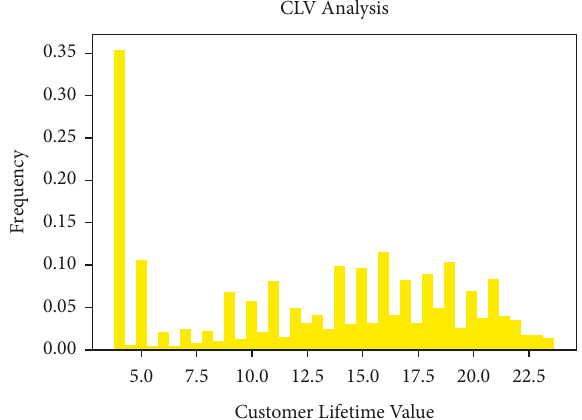
Figure 12: Ranking the IBM churners by